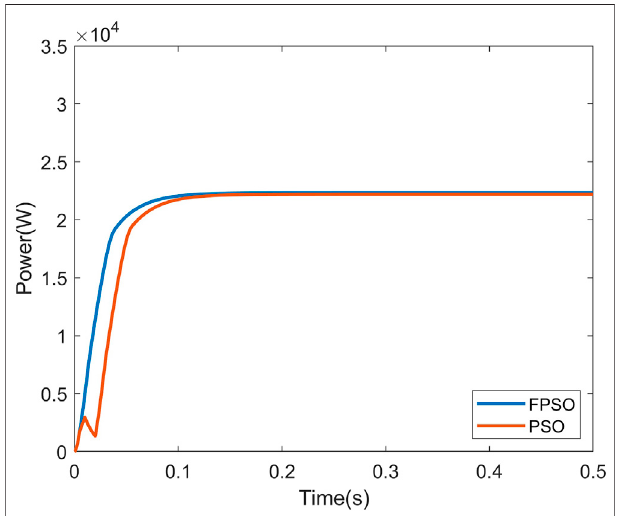
FIGURE 11 | Startup response of the fuzzy adaptive PSO and the convential PSO MPPT for irridiation 4.